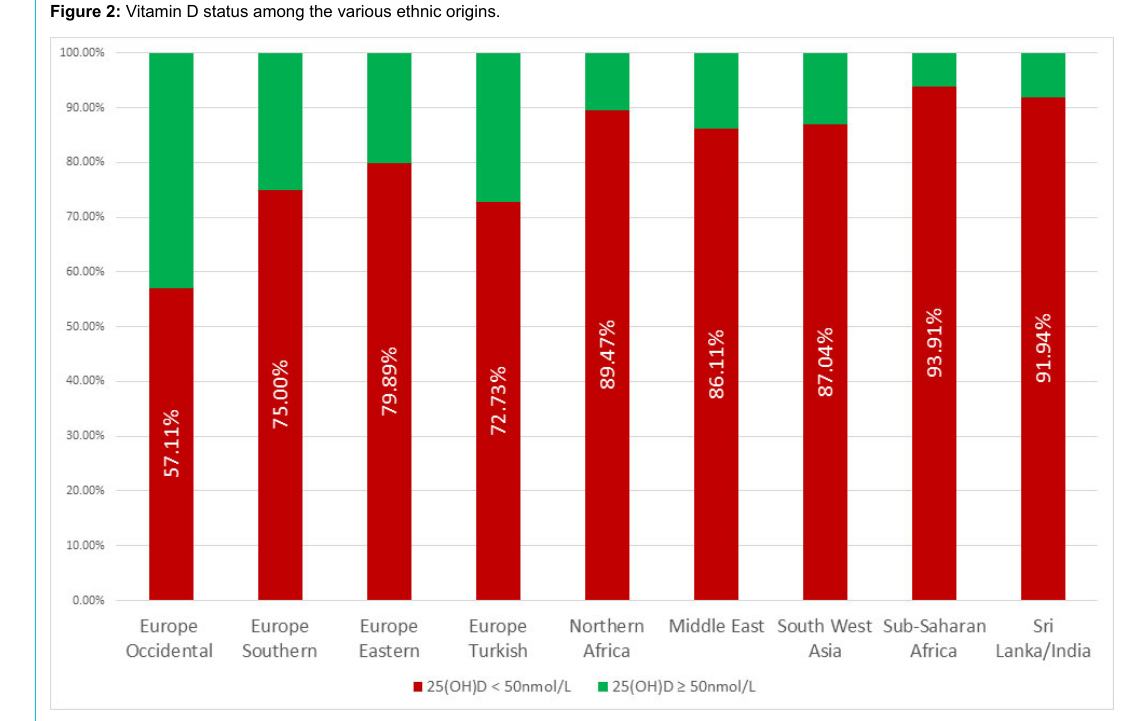
Figure 2: Vitamin D status among the various ethnic